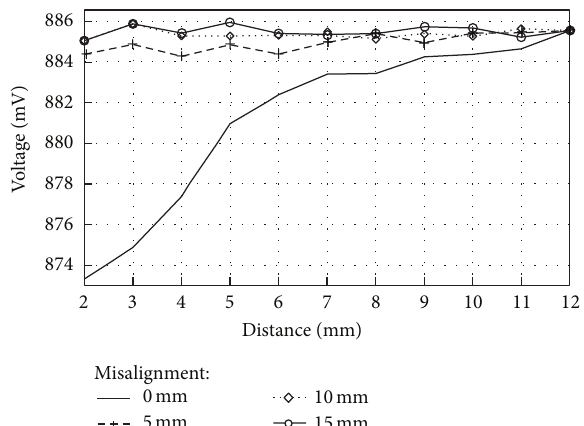
Figure 16: Voltage variations on reader coil versus distance. Trans- mission medium between coils: